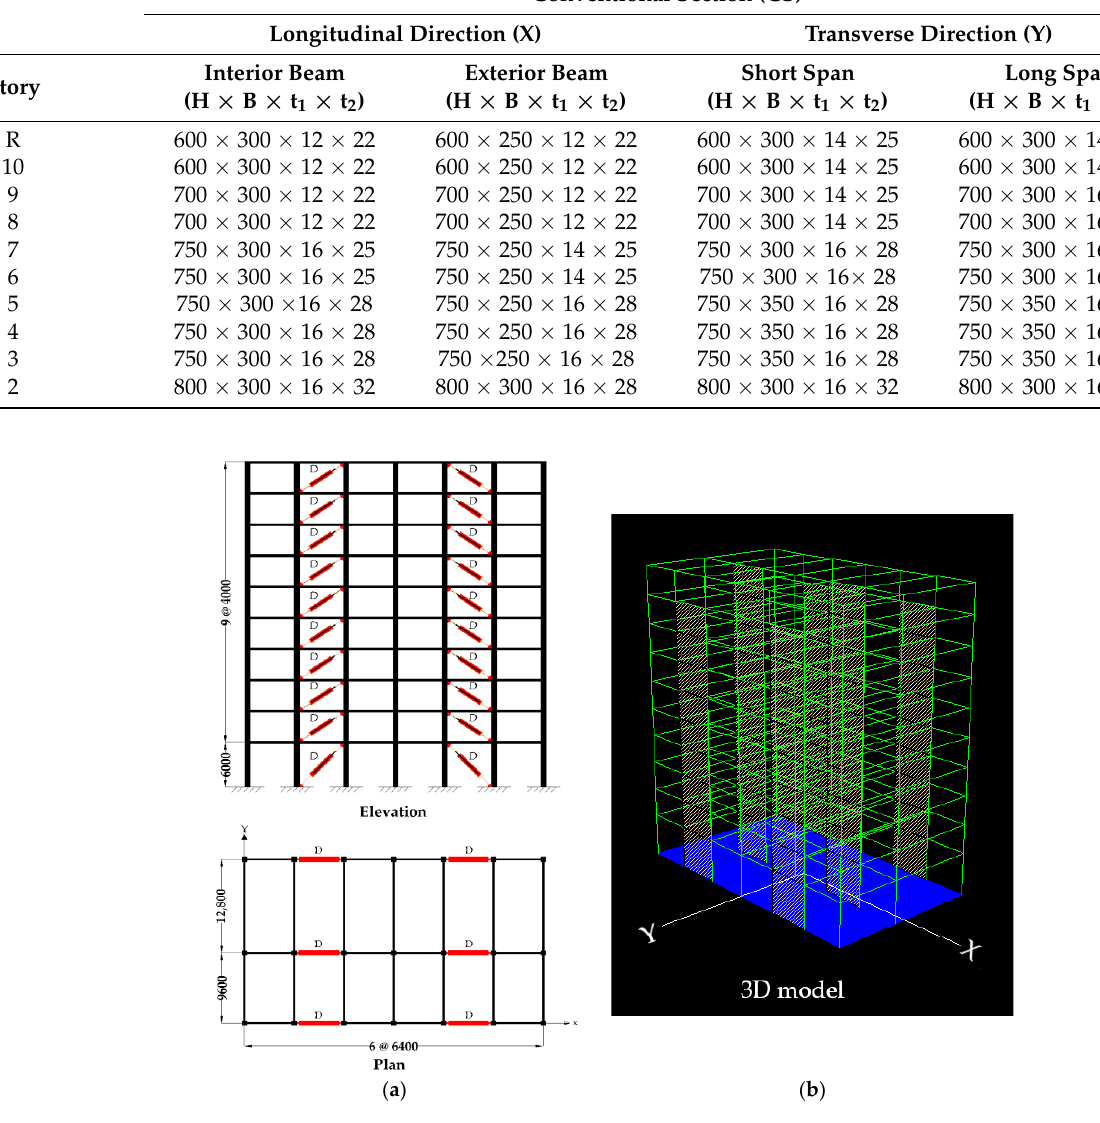
Figure 1. Target building (dimensions in mm): ( a ) plan, elevation, and damper configuration, ( b ) 3D model. Table 1. Description of building models with different damper arrangements.